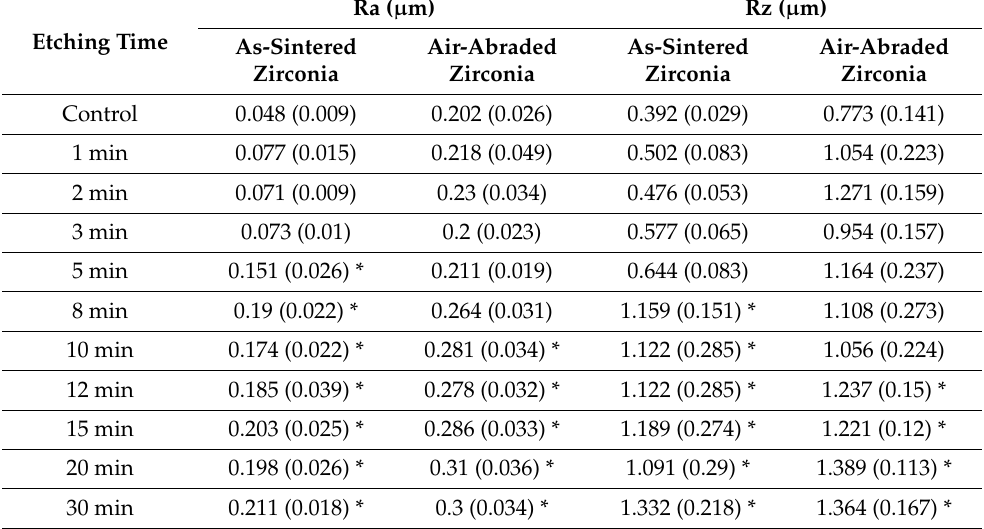
Table 1. Surface roughness (Ra, Rz) value (mean ± standard deviation) for as-sintered and air- abraded zirconia surfaces ( n = 5 per timepoint, µ m). The change in roughness with etching time is confirmed, and the roughness of both samples gradually increased with time. The asterisk indicates significance compared to the corresponding control specimen of the as-sintered and air-abraded zirconia ( p < 0.05). Ra ( µ m) Rz ( µ m) Etching Time As-Sintered Air-Abraded As-Sintered Air-Abraded Zirconia Zirconia Zirconia Zirconia Control 0.048